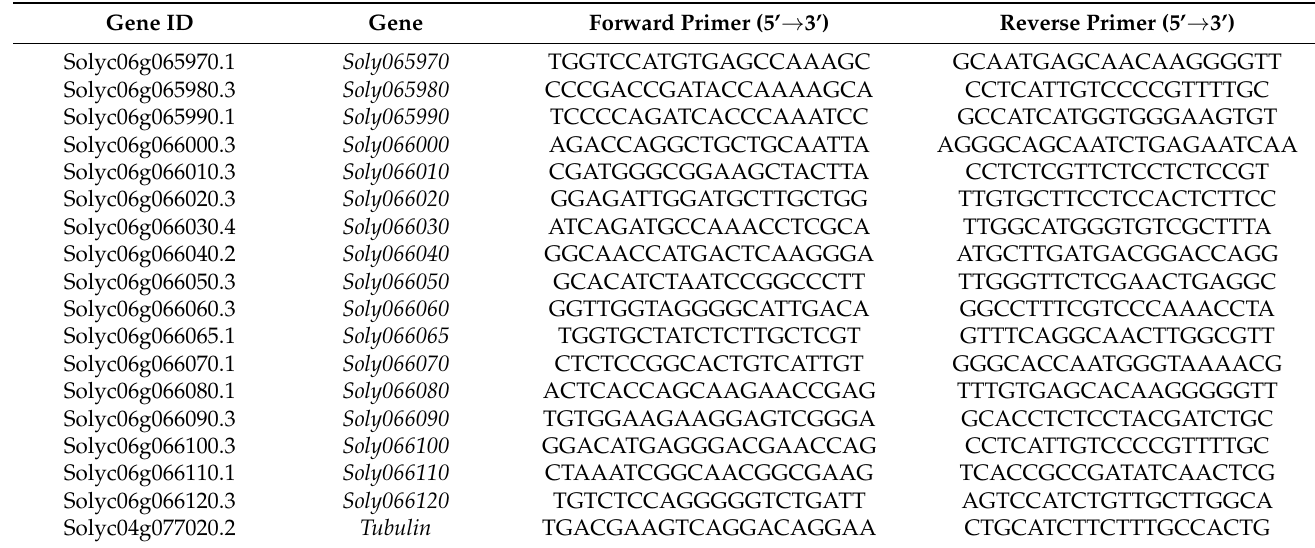
Table 1. Nucleotide sequences of primers used for